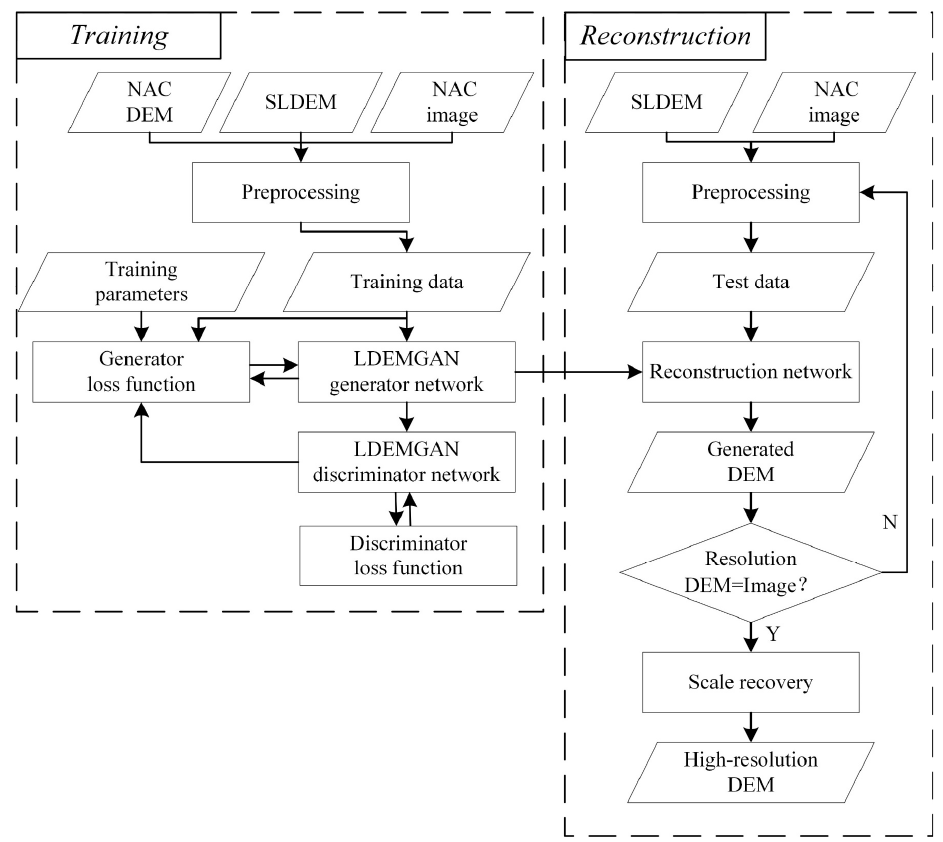
Figure 1. Overall process of the proposed method.